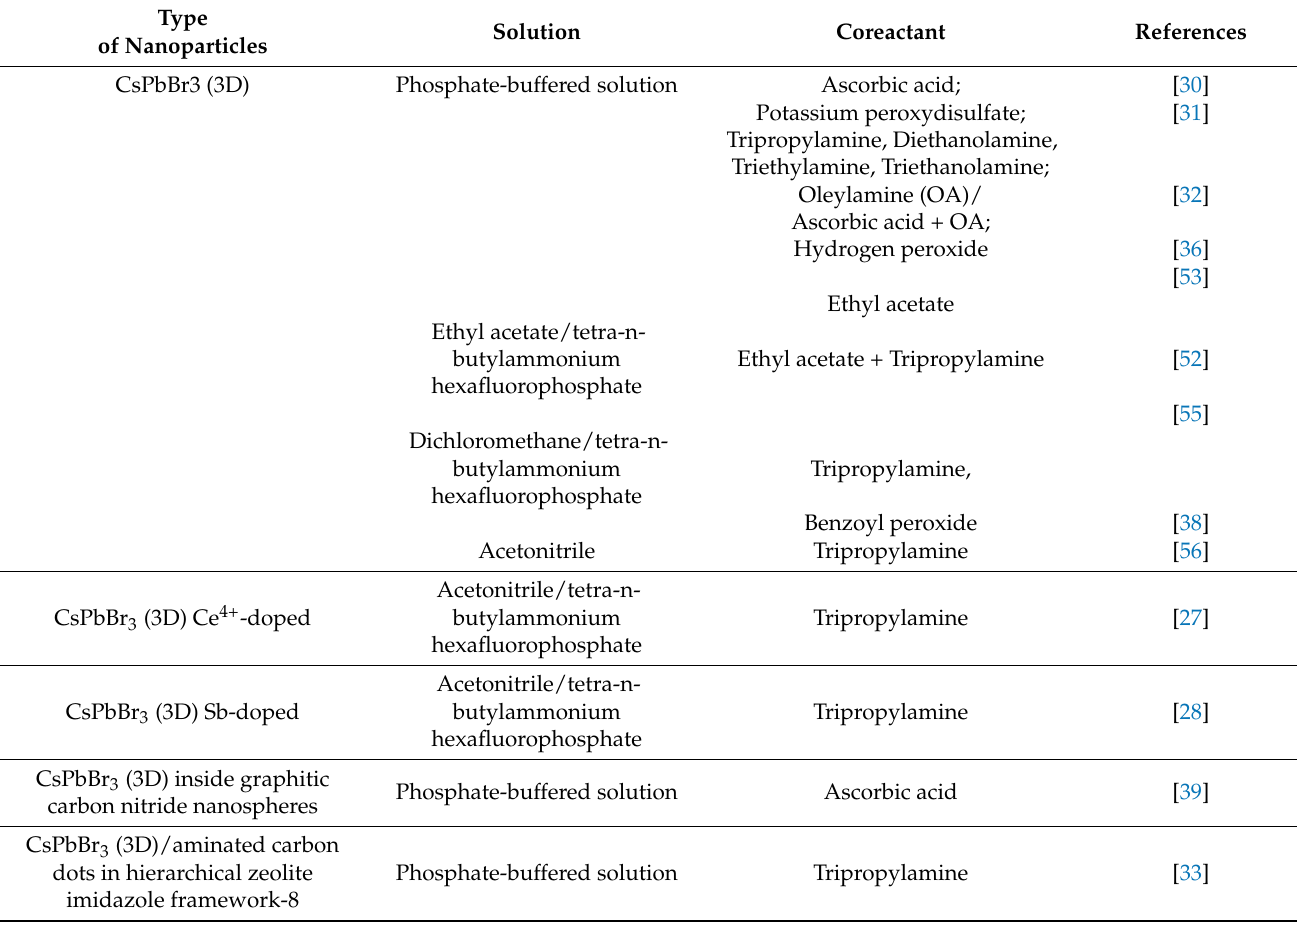
Table 1. Application of perovskite nanocrystals in coreactant